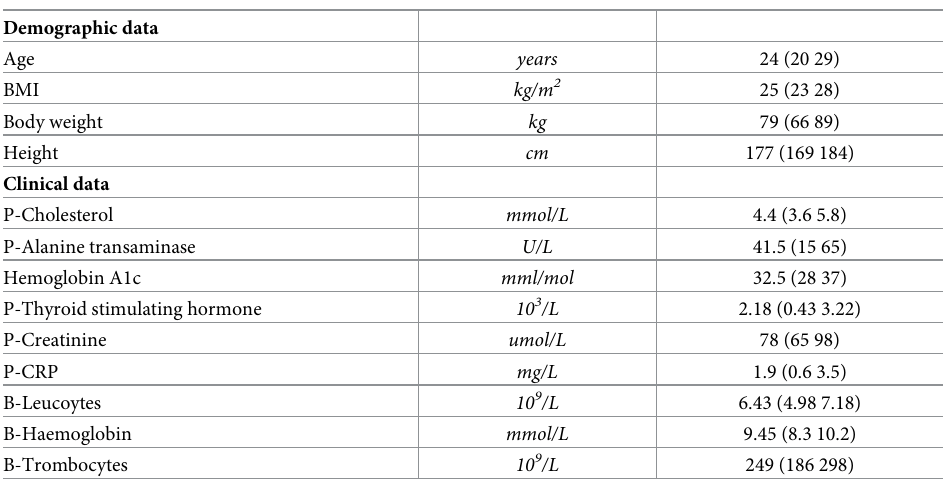
Table 1. Baseline charateristics.